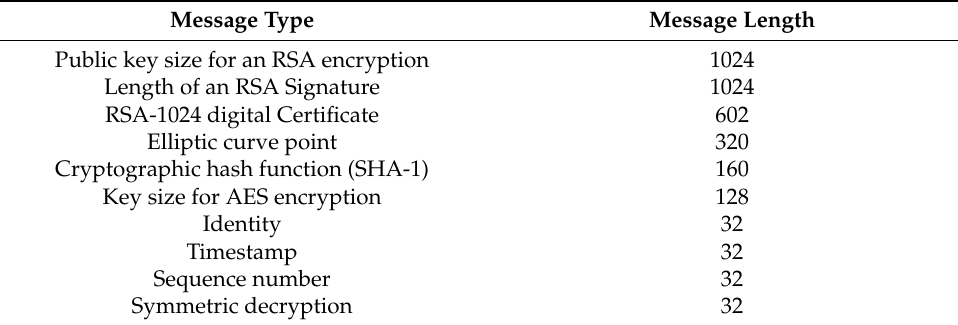
Table 6. Approximate message length in Bits.